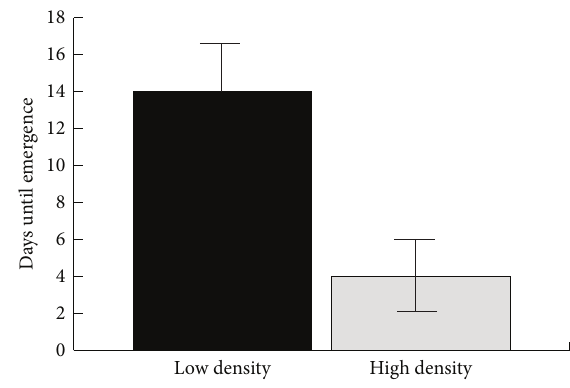
Figure 1: Days until emergence of last instar larvae reared with low and high conspecific